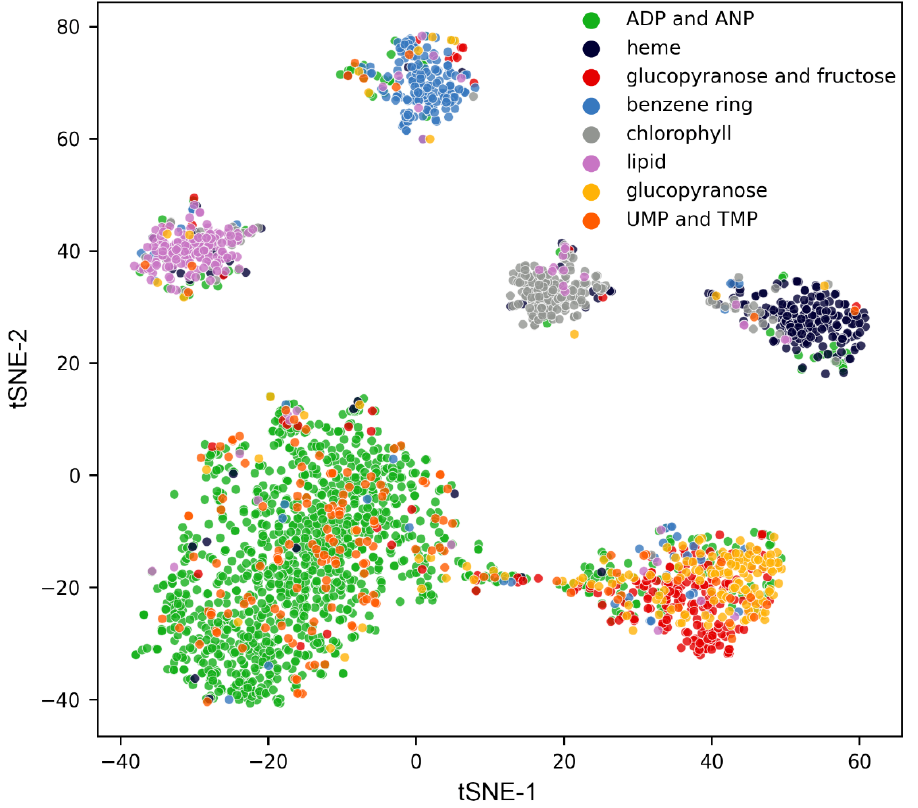
Figure 7. t-SNE visualization of embeddings generated by Siamese-GraphSite. Each dot represents one pocket colored by the cluster assignment.